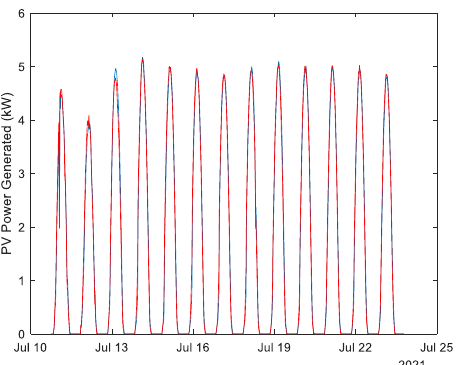
Figure 20. Measured (blue) and one-step-ahead predicted (red) PV power generated.